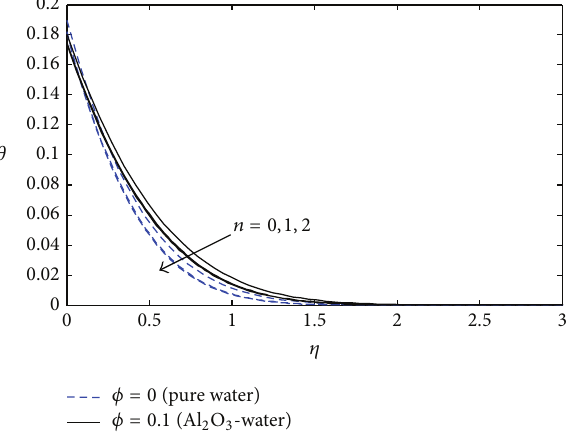
Figure 3: 𝑏 = 0.5 , 𝑓 𝑤 = 0.5 , Pr = 6.2 , 𝑀 = 0.5 , and 𝐴 = 0.5